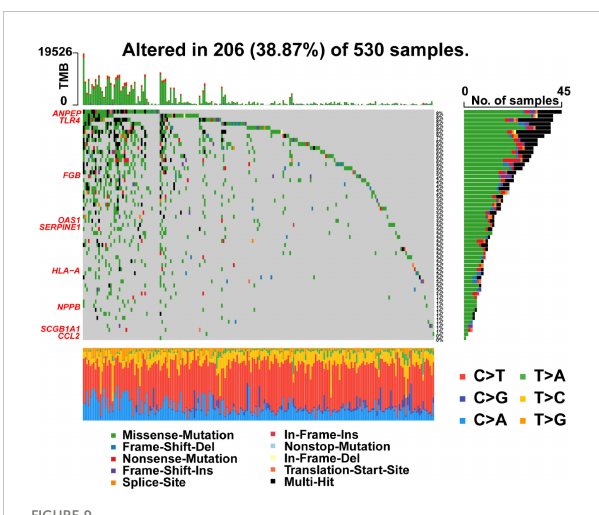
FIGURE 9 Landscape of mutations in 57 genes in UCEC. The left panel represents 9 prognostic genes which ordered by their mutation frequencies. The bottom panel represents 10 types of